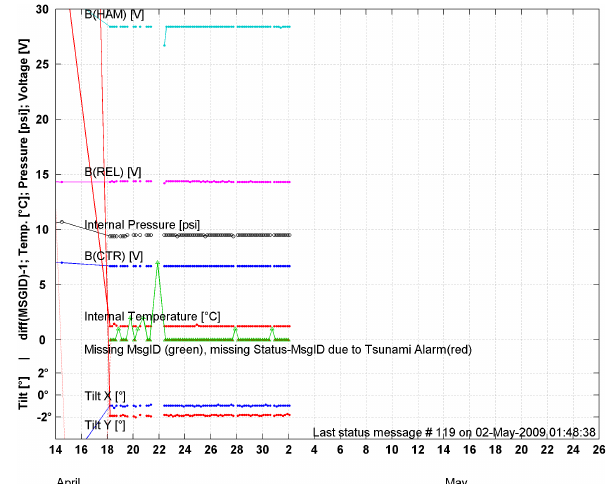
Fig. 17. Bottom pressure data during an externally triggered tsunami alarm on 19 April 2009 from position Sumatra 3. Blue dots: 10-min averages. Red dots: measured 15-s data; Green dots: pre- dicted data (based on cubic polynomial over past 3h). Dotted lines indicate 30mm tsunami threshold which is far outside the noise of the measurements during normal conditions. Vertical arrows show timing of alarm messages, vertical line of consecutive status mes- sage after the alarm timed out.